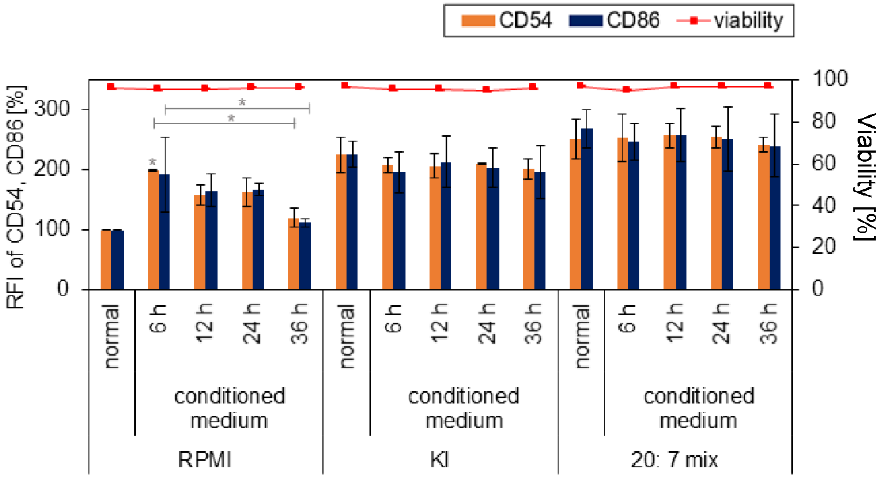
Figure 6. The effect of conditioned medium on cell viability and basal CD54 and CD86 expression on monocultured THP-1 cells. THP-1 cells were cultured in the conditioned medium in which keratinized NHEK cells were cultured for 6, 12, 24, and 36 h, and cell viability and their expression of CD54 and CD86 were analyzed using flow cytometry. Data are shown as relative fluorescence intensity (RFI, % of control). Mean values of RFI ± SD for three individual experiments are shown. * p < 0.05, significantly different from the control (“normal”) (by ANOVA followed by Dunnett’s test).